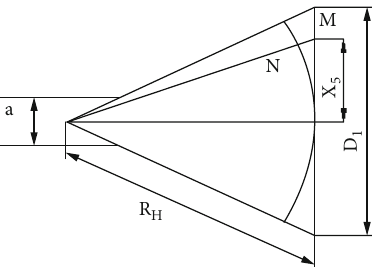
Figure 3: The position relation of the horn